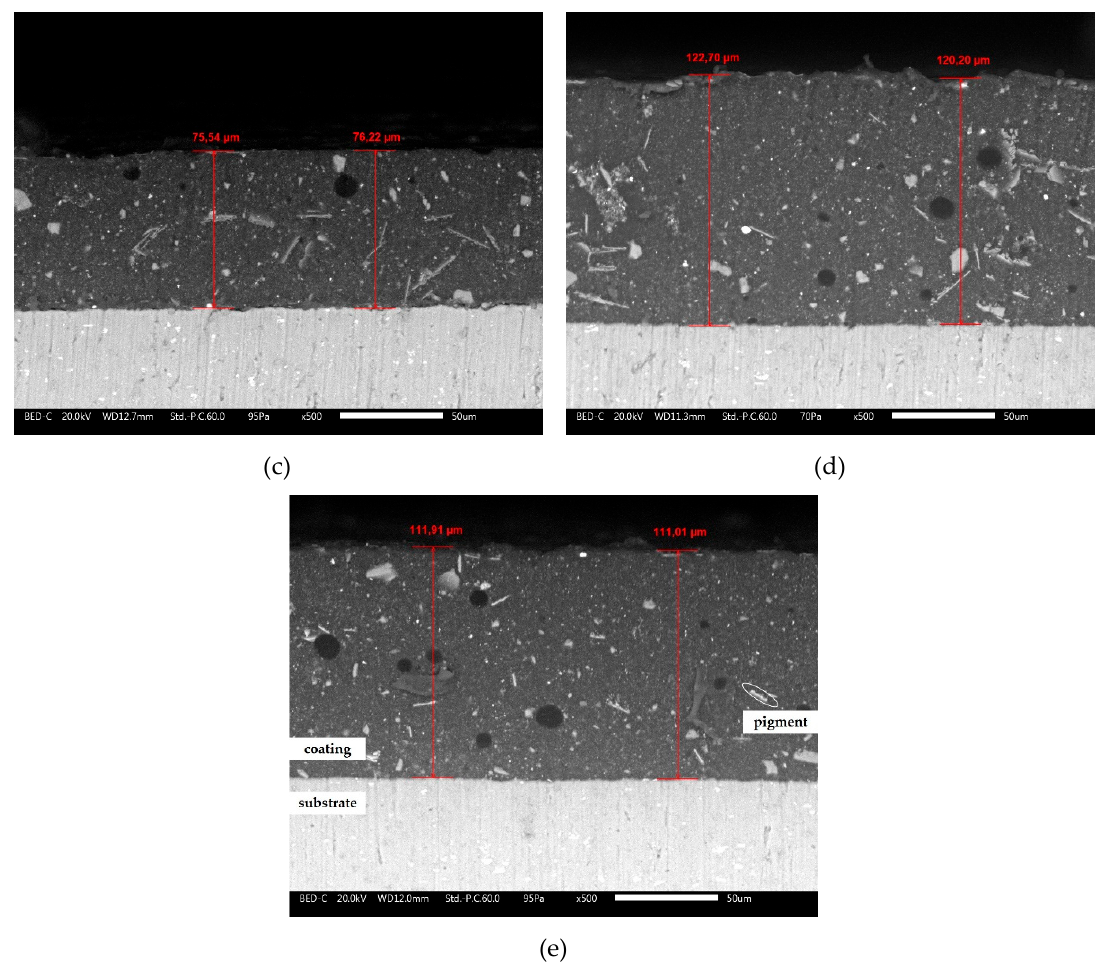
Figure 2. Scanning electron microscope cross sections of the sample: ( a ) GB-SW; ( b ) GB-WNT; ( c ) LG; ( d ) PS; and ( e ) TB. In ( e ), a description of the components of the sample is made.